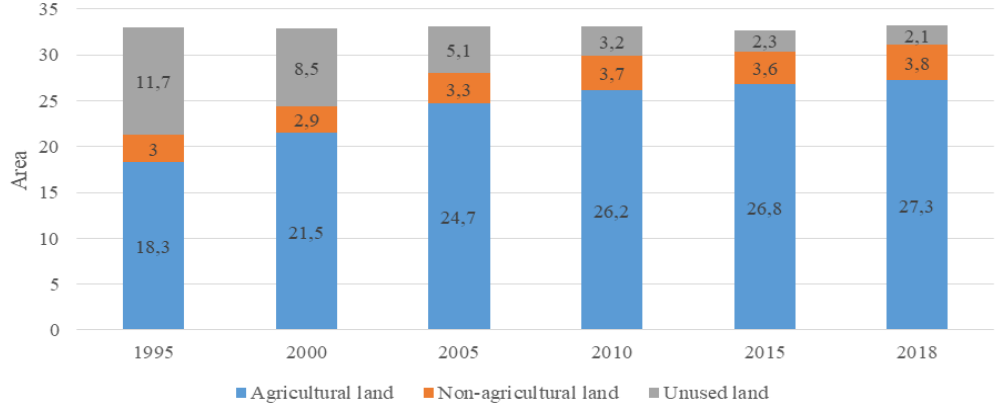
Fig. 2. Changes in the area of land uses in the period 1995–2018 (Unit: Million ha; Source: GSO